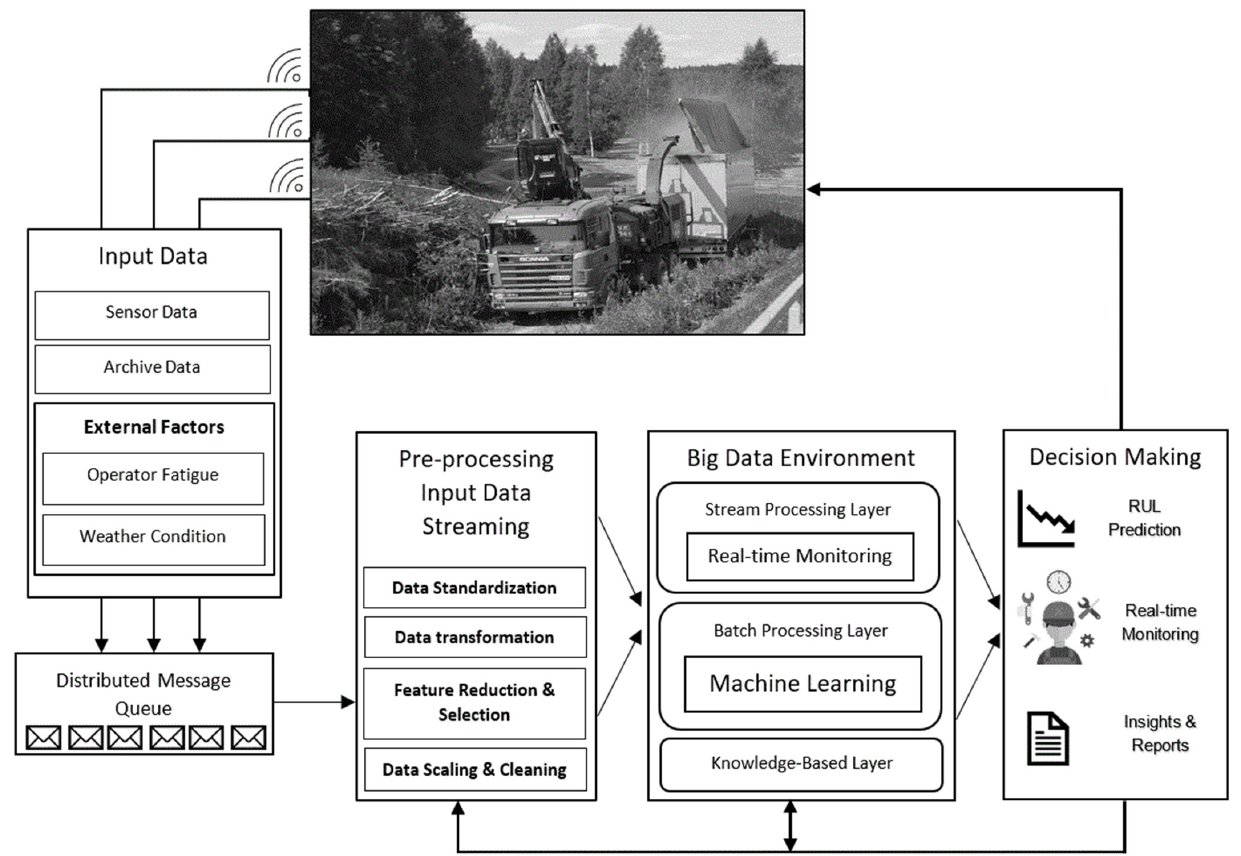
Figure 6. Conceptual IPdM framework for biomass forestry.